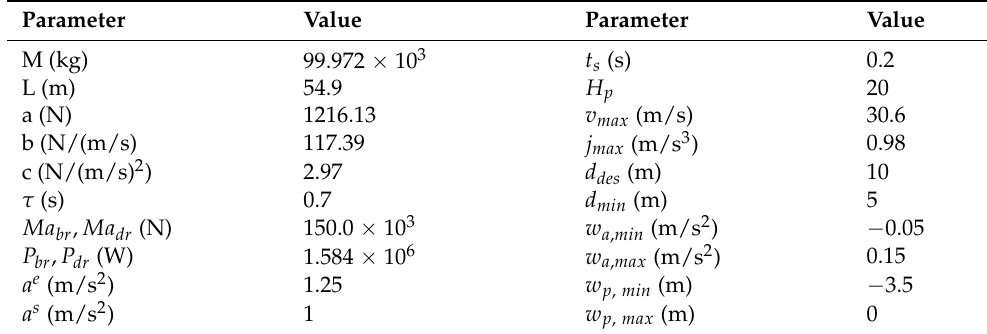
Table A1. Parameters used in the